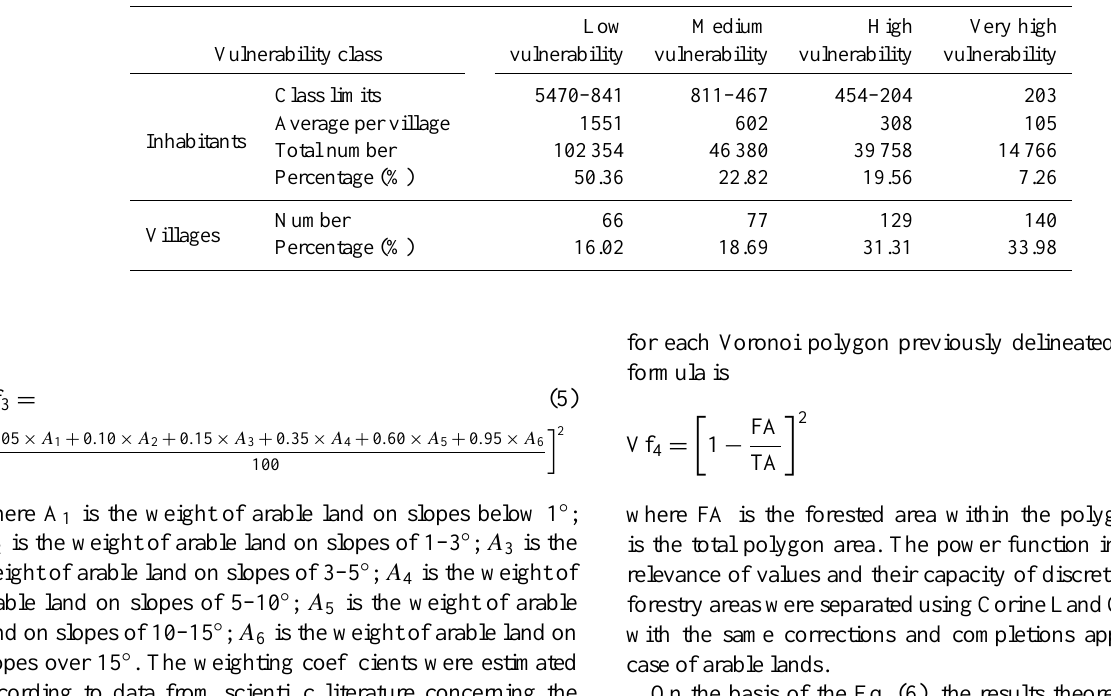
Table 2. Synthetic data of vulnerability factor 1 in Tutova